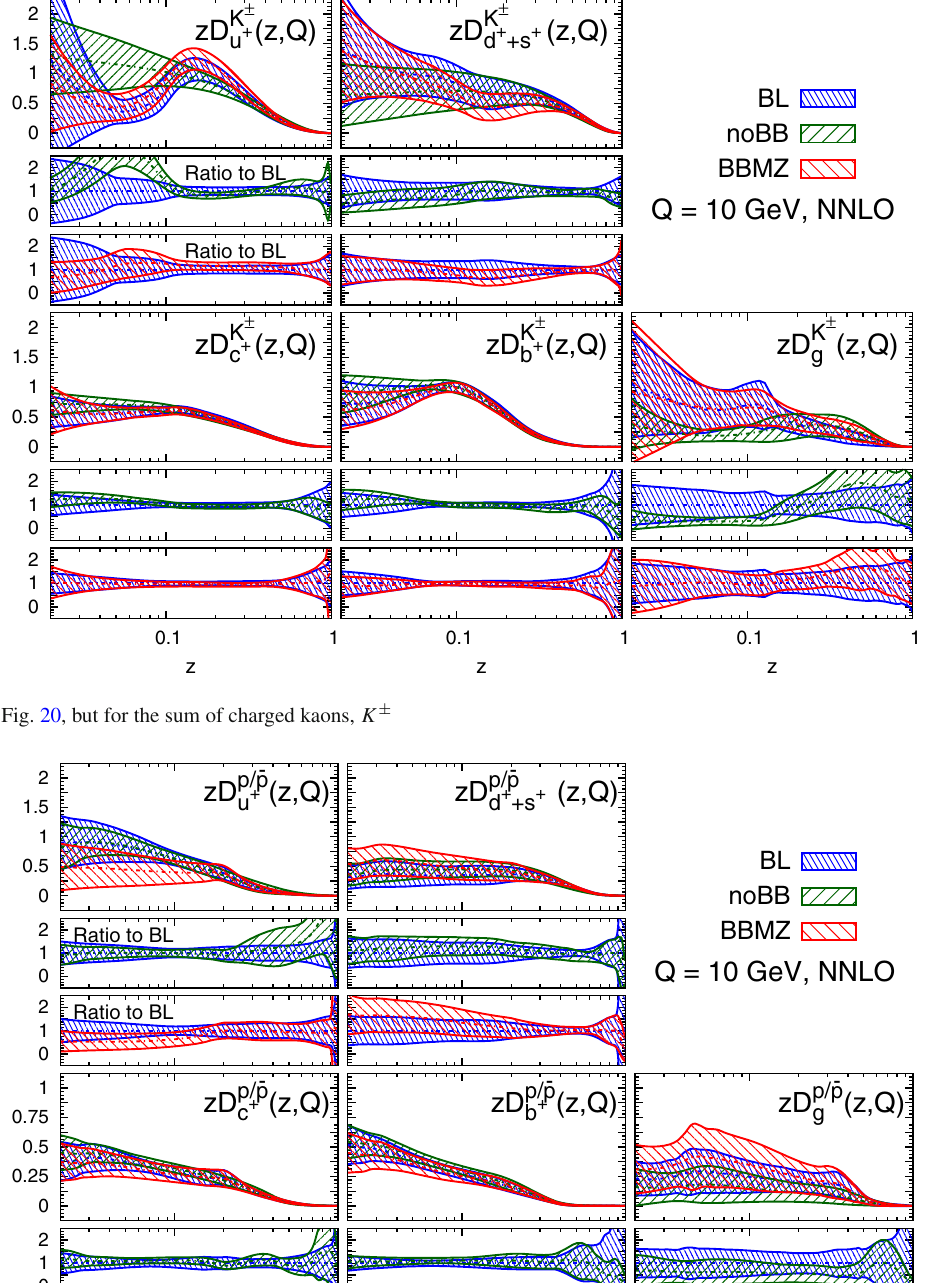
Fig. 22 Same as Fig. 20, but for the sum of protons and antiprotons, p / ¯ p